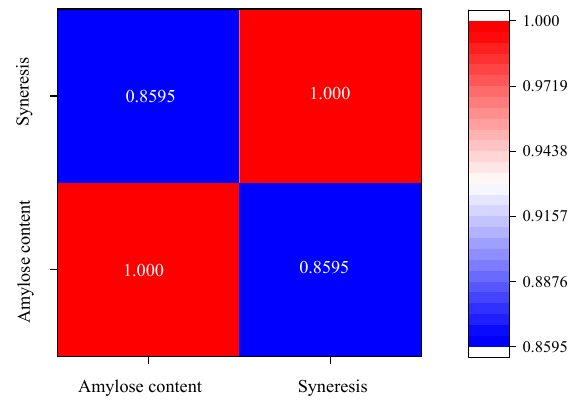
Figure 5. Correlation between Amylose content and syneresis.